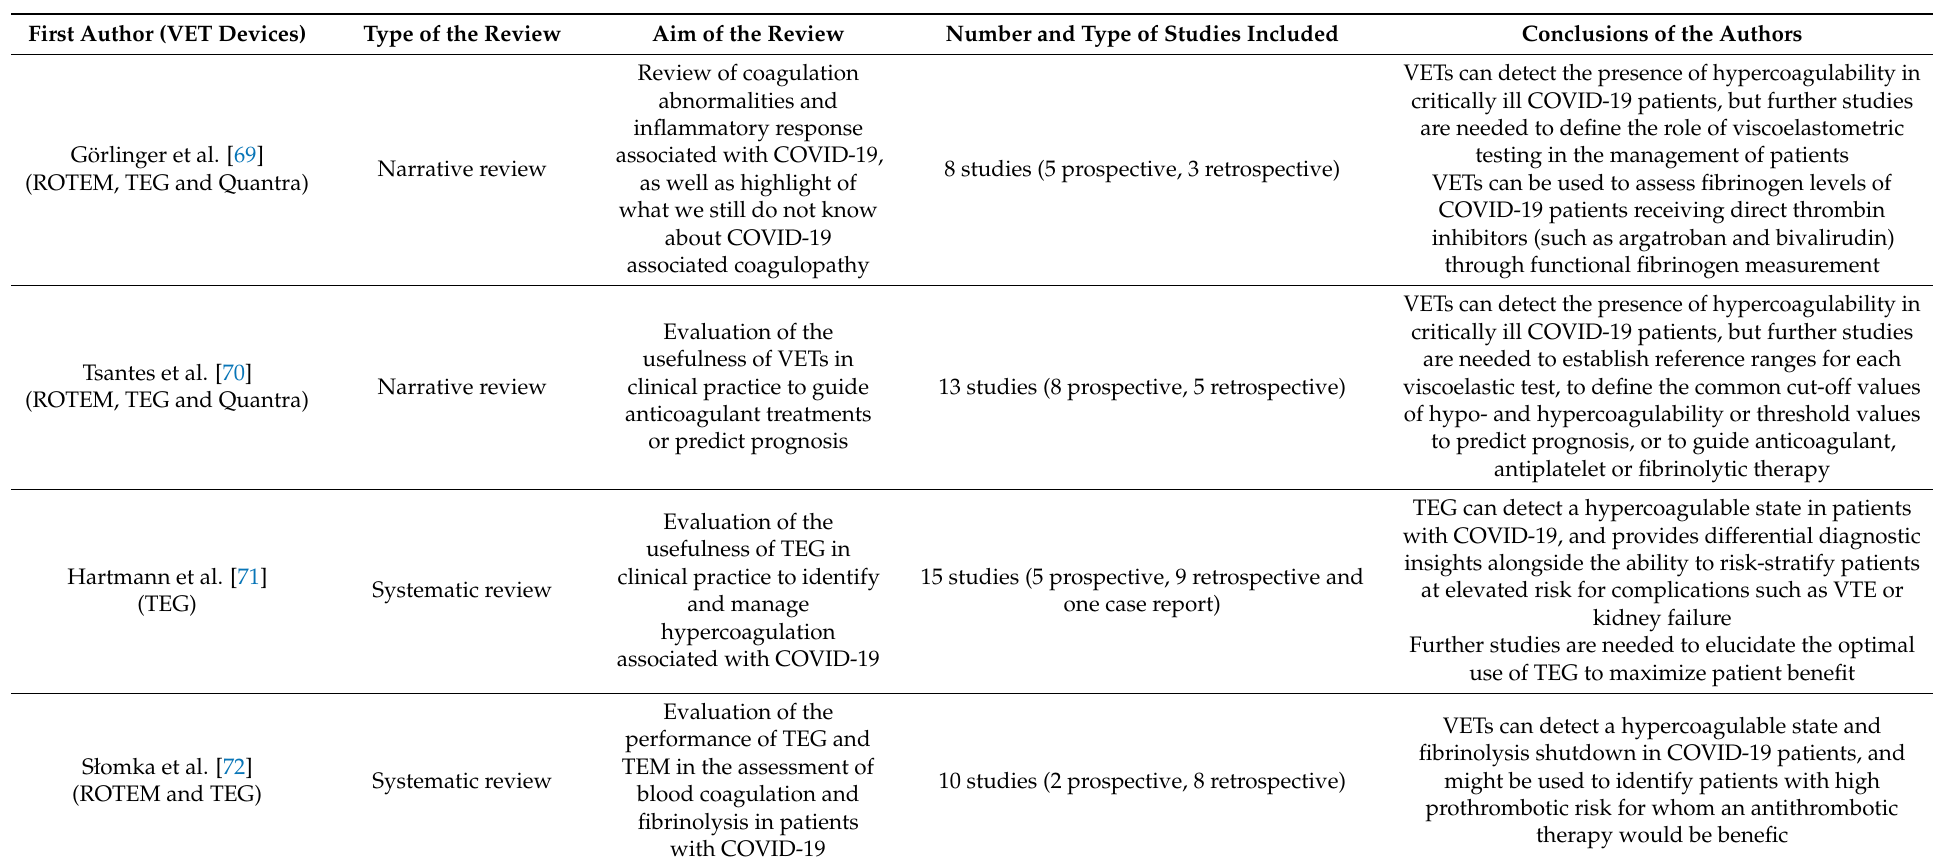
Table 11. Conclusions of the previously published